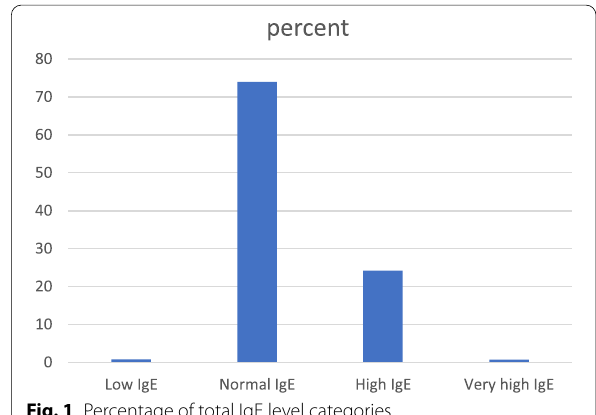
Fig. 1 Percentage of total IgE level categories